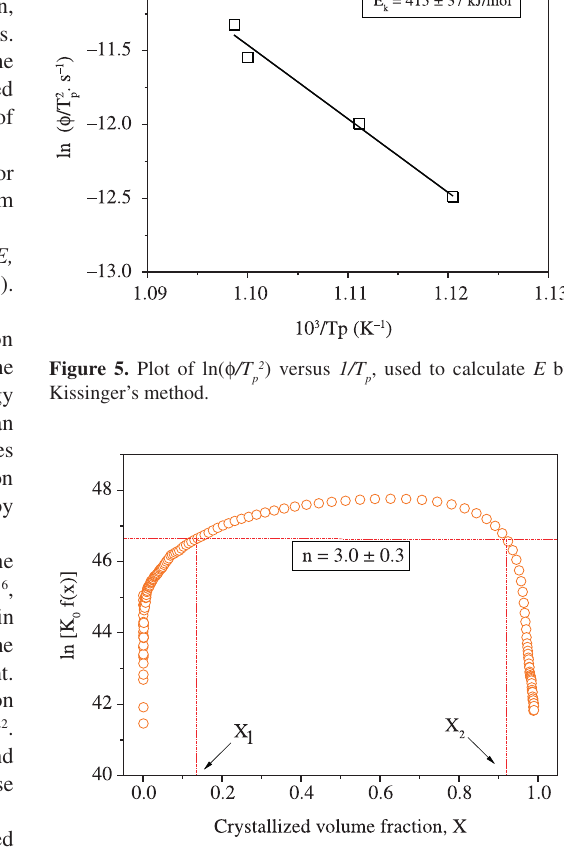
and x ), for which 1 2 and x values, the 1 2